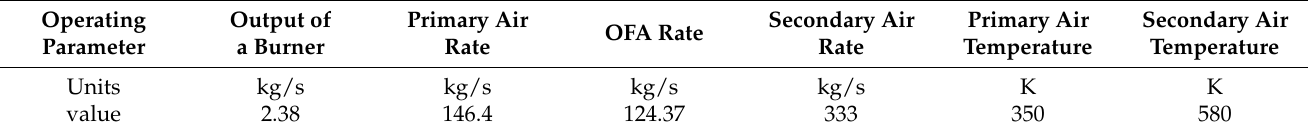
Table 1. Main operating parameters of the base operation condition (BMCR: 600 MW).